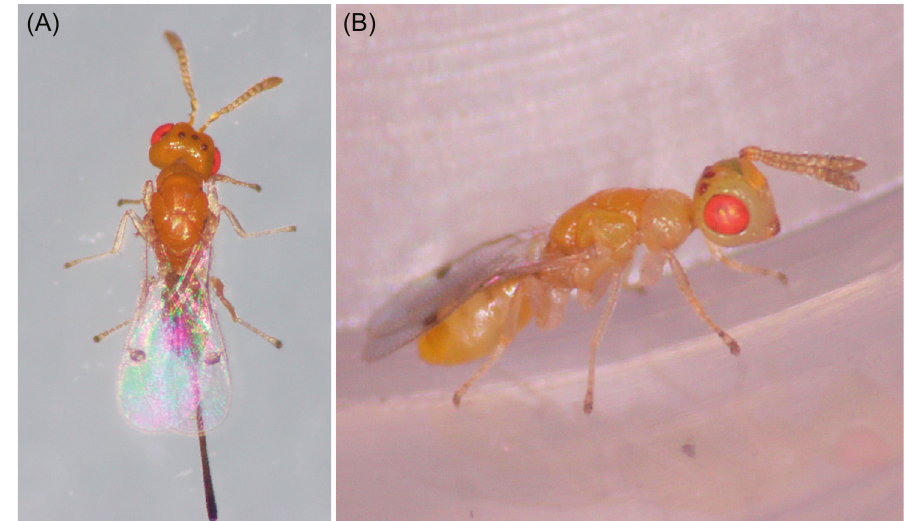
Figure 5. (A) Dorsal view of Megastigmus viggianii female; (B) profile view of M. viggianii